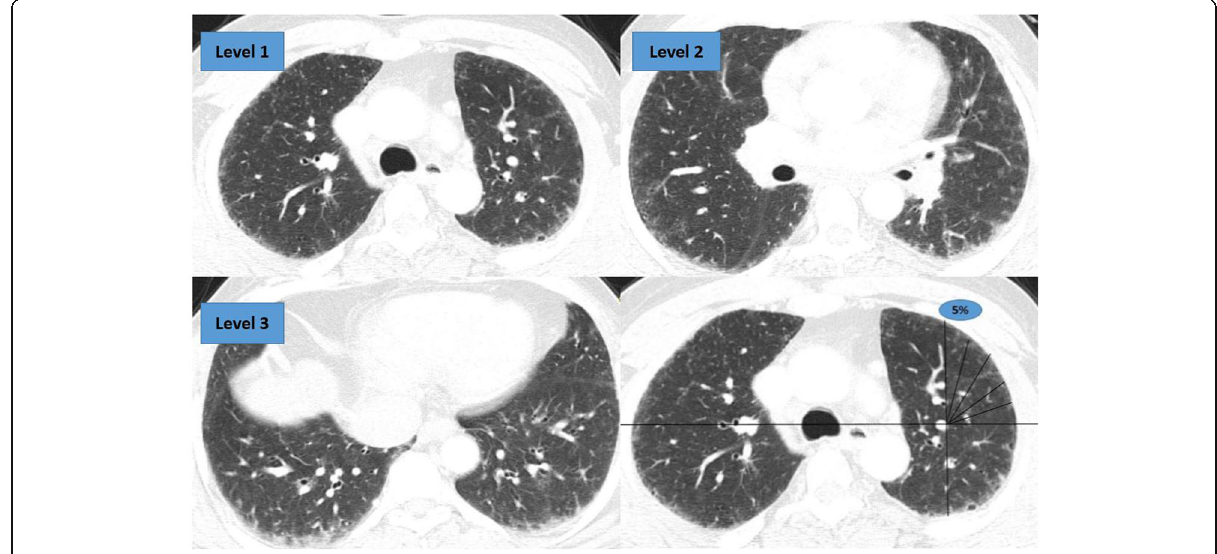
Fig. 1 Semi-quantitative visual method for assessment of predominant ILD pattern: levels of HRCT and slices